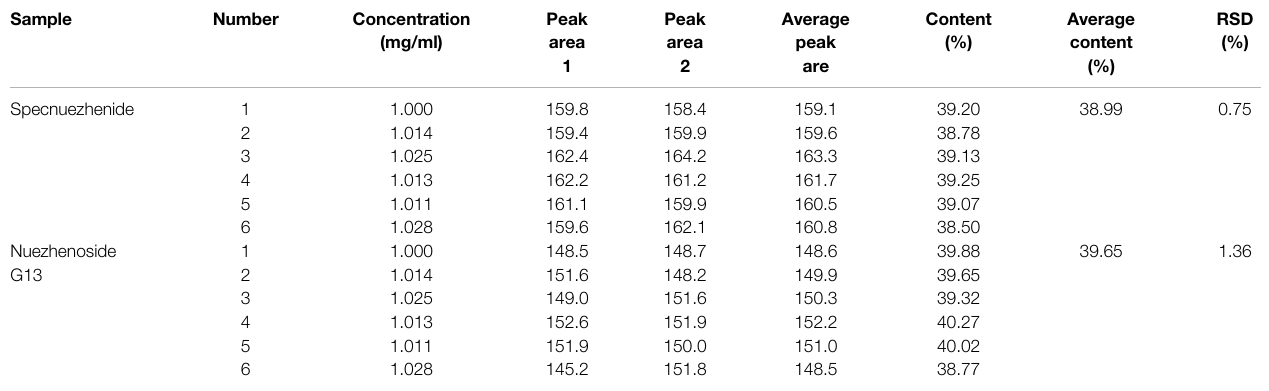
TABLE 3 | The repeatability test results of Specnuezhenide and Nuezhenoside G13. Sample